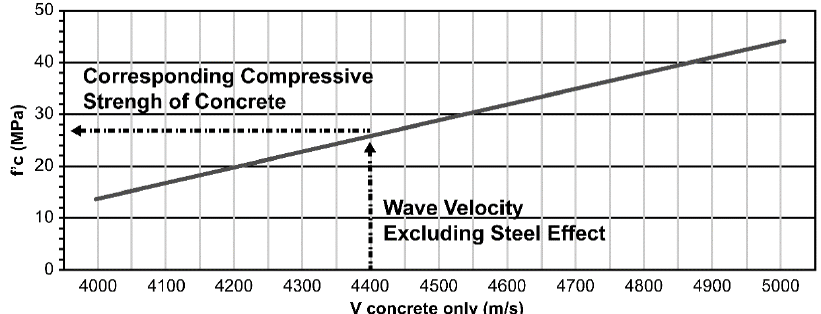
Figure 12. Velocity vs.compressive strength.